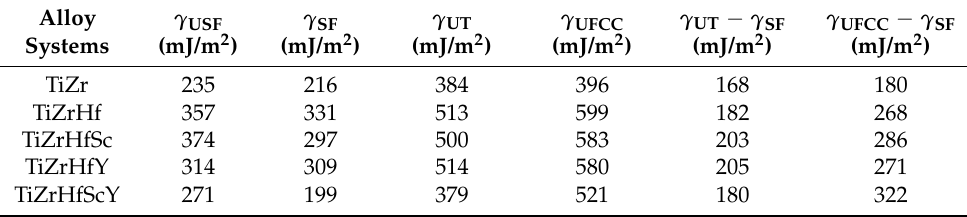
Table 3. The calculated unstable stacking-fault energy ( γ USF ), stacking-fault energy ( γ SF ), unstable twinning-fault energy ( γ UT ), and unstable FCC-fault energy ( γ UFCC ) and energy barriers for the formation of twin fault and FCC fault with pre-existing stacking faults for the TiZr-based CSAs.